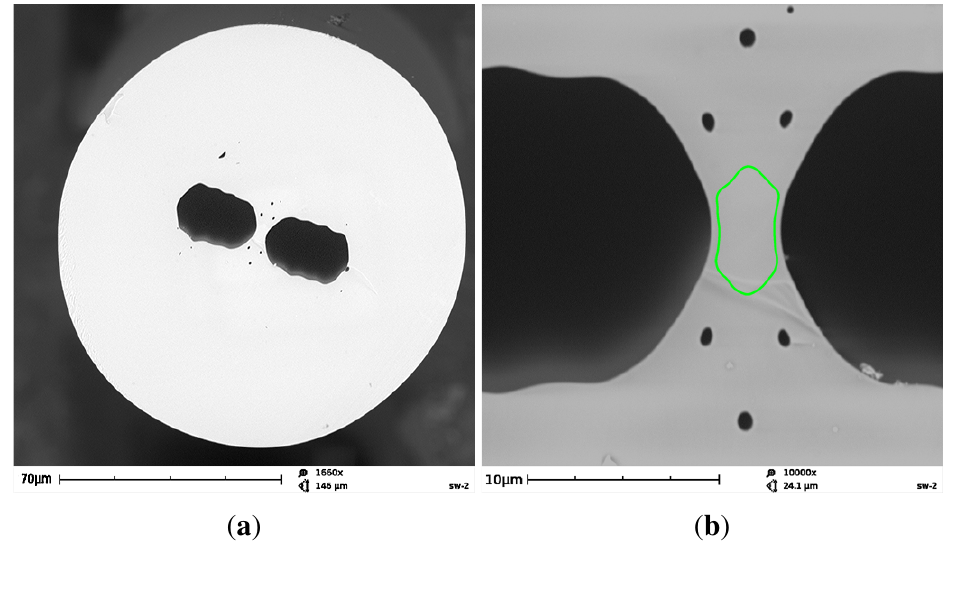
Figure 3. Structure of the FUT: general view of the fiber cross-section ( a ). Enlarged image of the central region with the green line showing the core boundary ( b